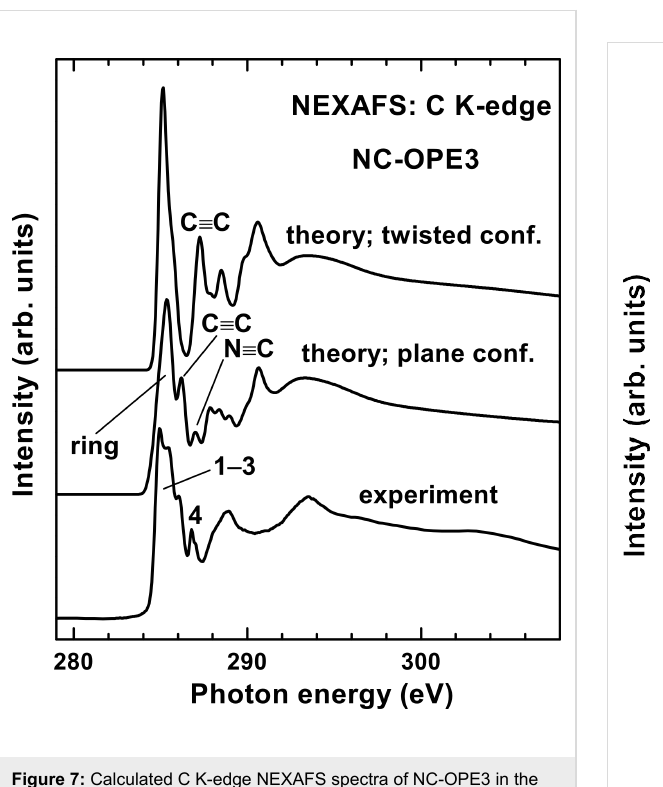
Figure 7: Calculated C K-edge NEXAFS spectra of NC-OPE3 in the planar and twisted conformations, along with the experimental spec- trum of NC-OPE3/Au taken at an X-ray incidence angle of 55°. The theoretical spectra were shifted by ca. 1.3 eV to lower photon ener- gies in order to align the most intense π * resonances in the theoretical and experimental spectra. The most prominent absorption resonances in the experimental spectrum are marked by numbers. The most prominent absorption resonances in the theoretical spectrum are marked by the functional groups that are associated with these reso- nances.